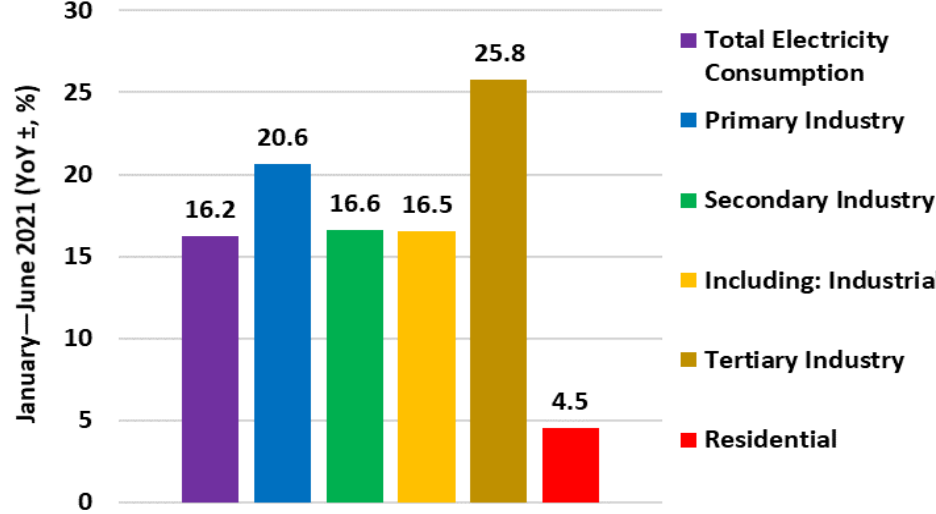
Figure 16. Sector-wise electricity consumption in January–June 2021.